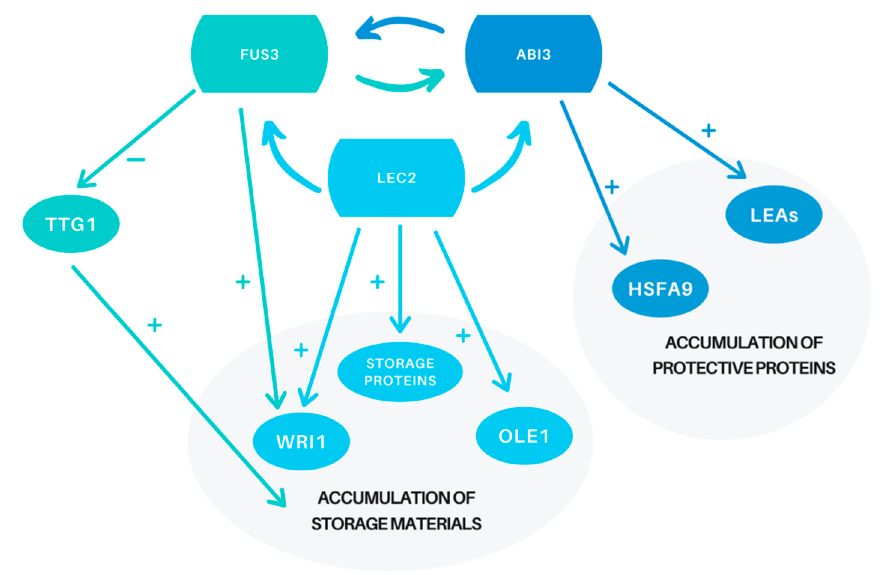
Figure 1. Simplified diagram illustrating the e ff ect of B3 transcription factors during the maturation of seeds. a.—FUS3 represses TRANSPARENT TESTA GLABRA 1 (TTG1) transcription factor (TF), which is a negative regulator of genes related to fatty acid and storage protein biosynthesis, and positively regulates WRINKLED 1 (WRI1), an inducer of fatty acid biosynthesis; thus, FUS3 indirectly positively a ff ects the accumulation of storage materials. FUS3 also regulates ABI3 expression in the lateral parts of cotyledons. b.—LEC2 regulates other B3 transcription factors—FUS3 and ABI3, preventing anthocyanin and chlorophyll accumulation and by positive regulation of WRI1 and OLE1 takes part in intensified fatty acid biosynthesis and storage; LEC2 also positively regulates the expression of 2S and 12S storage proteins. c.—ABI3 regulates expression of FUS3 in the embryo axis and cotyledons and indirectly takes part in the accumulation of heat shock protective proteins by positive regulation of HSFA9 TF; ABI3 is a master regulator of late embryogenesis abundant (LEA) protective proteins.